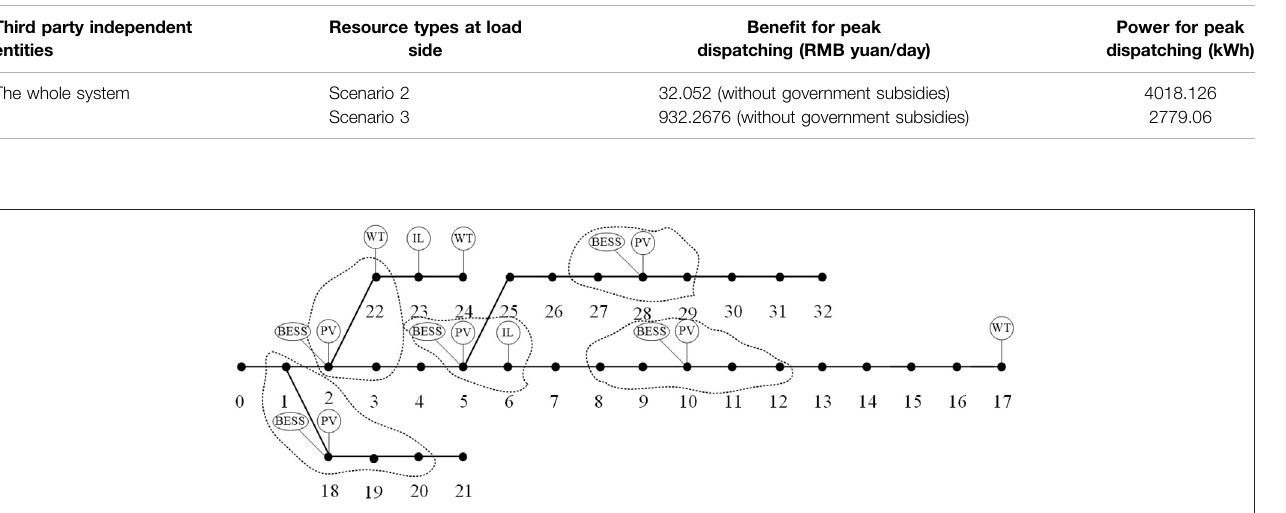
FIGURE 9 | Islanding division result.